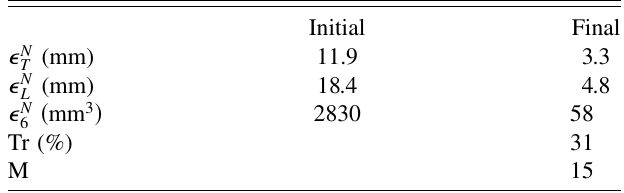
TABLE IV. Emittance performance of the realistic RFOFO cooling ring.